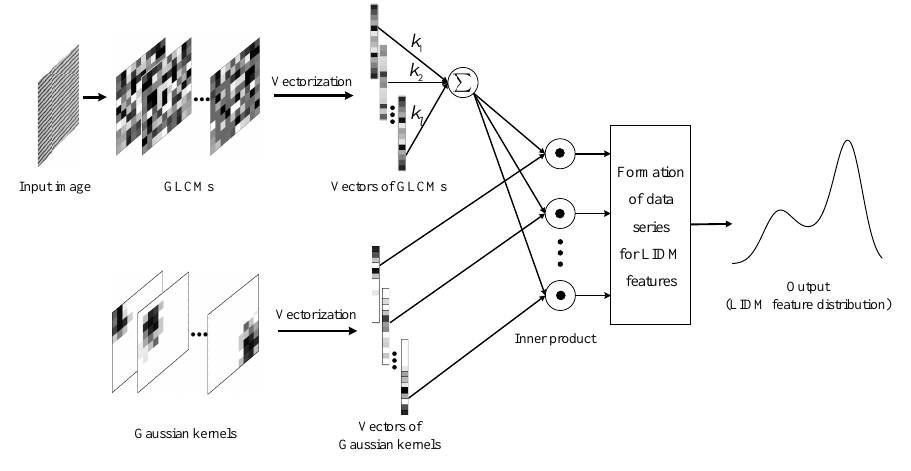
Figure 4. The extraction procedure of LIDM feature